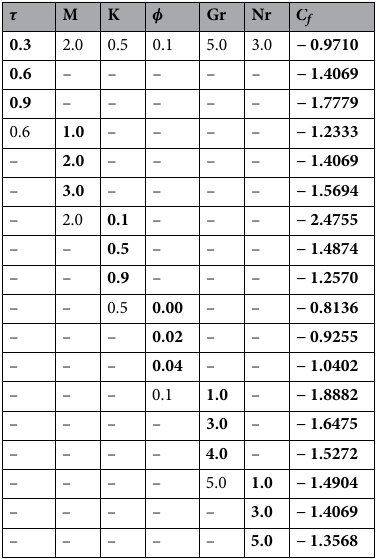
Table 2. Skin friction (shear stress) for variation of several parameters. The consecutive bold values of a parameter exhibit the variation in that